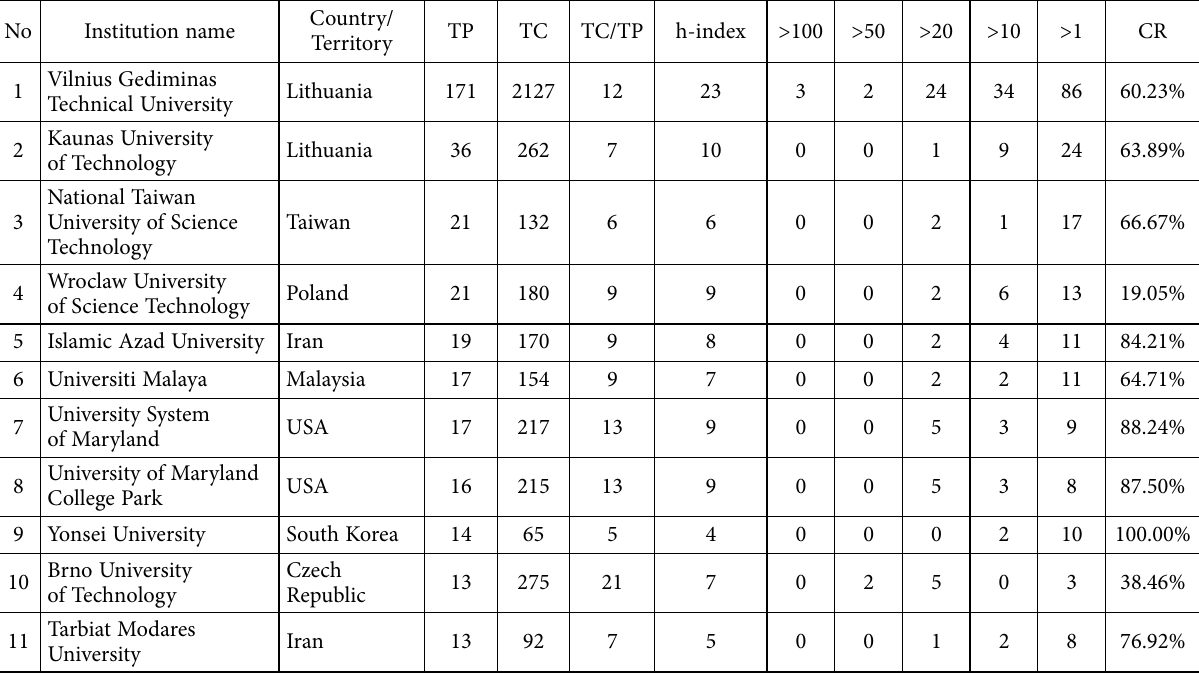
Table 5. Top 20 productive institutions during 2008–2018